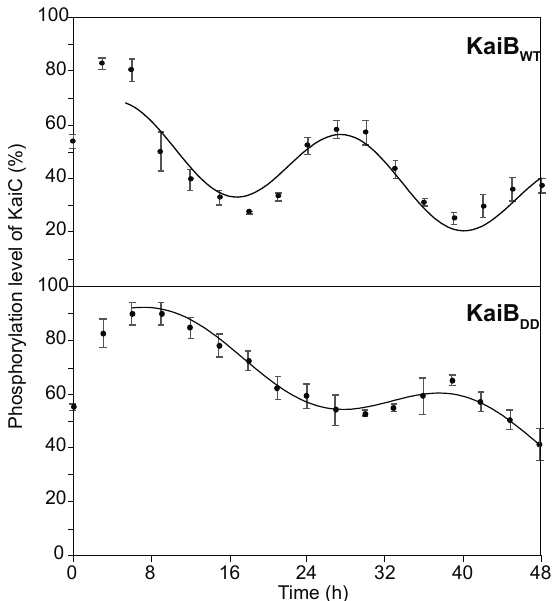
Figure 6. Circadian oscillations in vitro. Phosphorylated KaiC levels in the presence of wild-type SyKaiB and its mutant SyKaiB DD . Plots show the percentage ratios of phosphorylated KaiC to total KaiC in the presence of KaiB WT and KaiB DD . The relative amounts of unphosphorylated and phosphorylated KaiC were estimated using densitometry. The data represent the means ± SD from three independent experiments. The simulated time course showing circadian oscillations in the phosphorylated KaiC level were generated using an integrated rhythm-analyzing program [27].